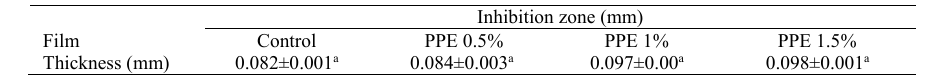
Table 1. Thickness properties of chitosan-ZnO films containing different concentrations of pomegranate peel extract (PPE)